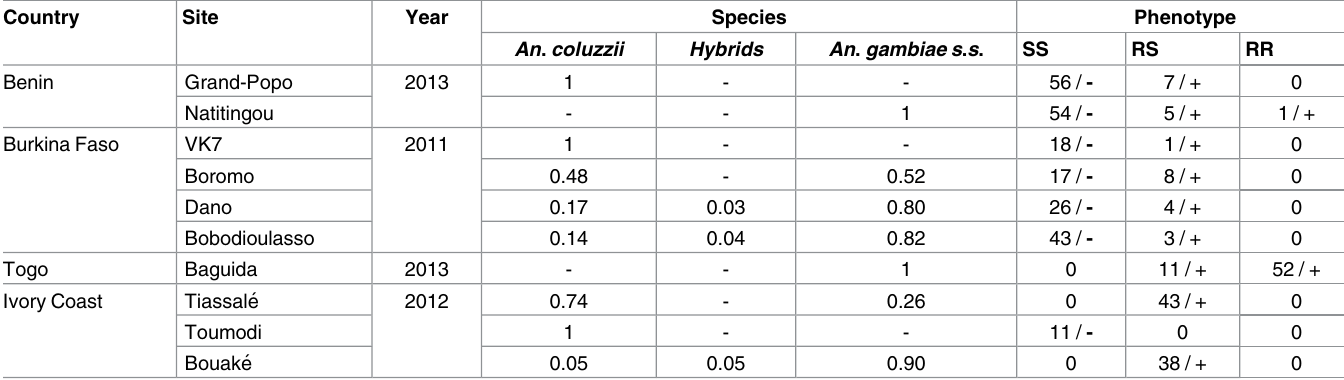
Table 1. Screening for the presence(+) or absence (-) of the ace-1 duplication in West African An . gambiae populations. Country